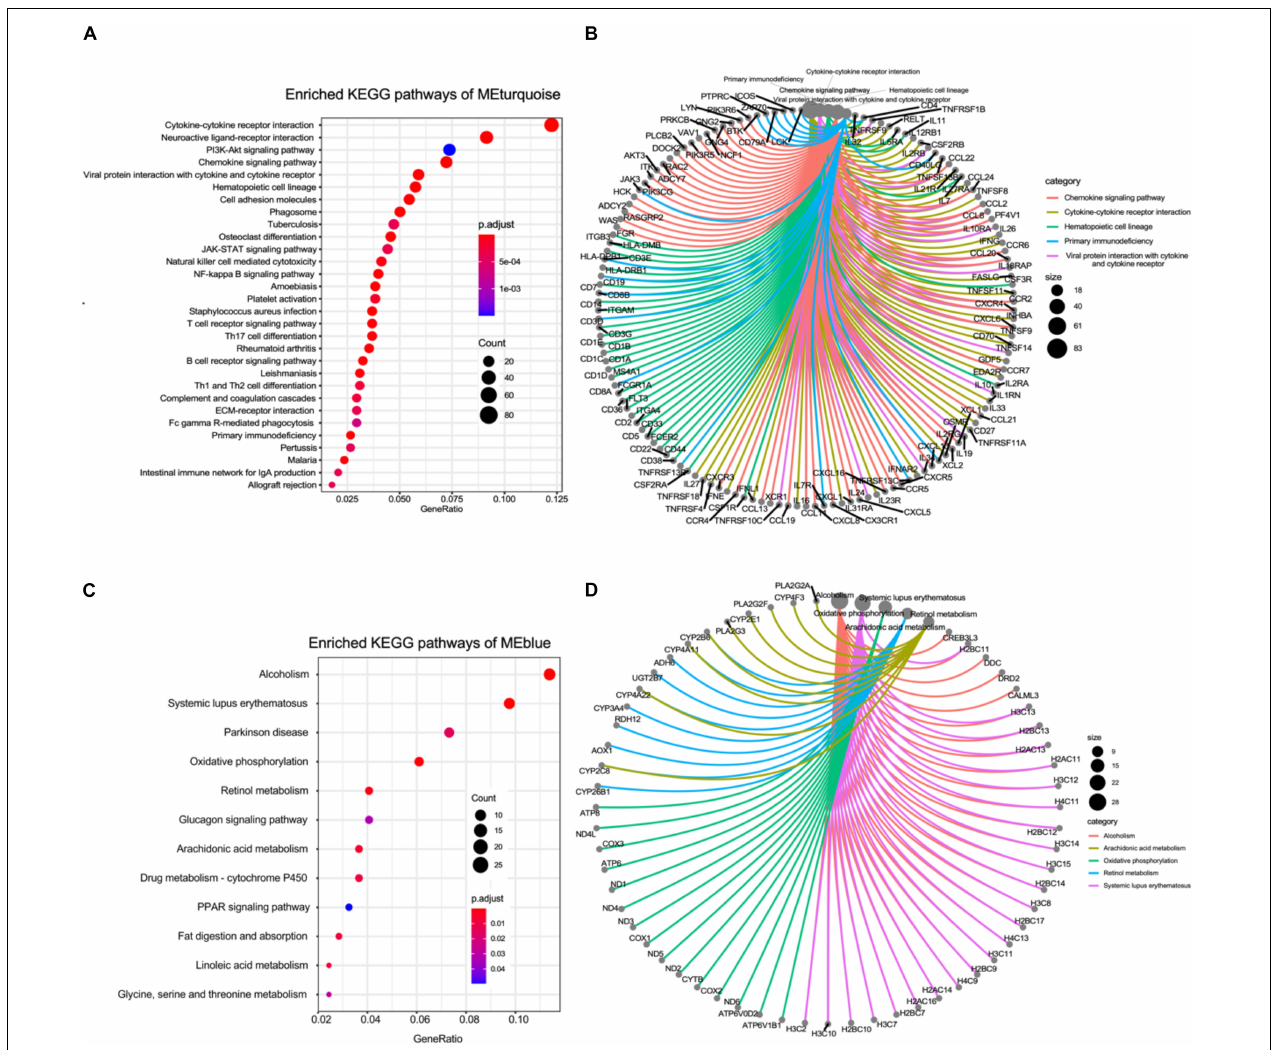
FIGURE 2 | KEGG pathway enrichment of the co-expression gene modules. (A) The bubble plot showing the enriched KEGG pathways of genes in turquoise module. (B) The circle network plot showing the shared genes between several KEGG pathways enriched in turquoise module. (C) The bubble plot showing the enriched KEGG pathways of genes in blue module. (D) The circle network plot showing the shared genes between several KEGG pathways enriched in blue module.